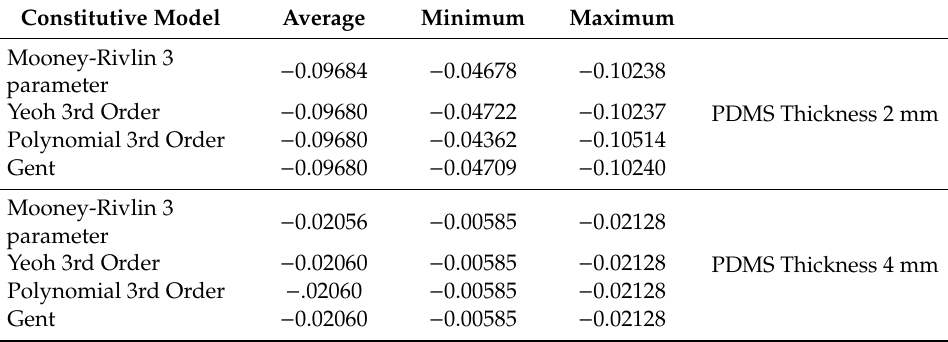
Figure 13. Shear strain obtained numerically and experimentally along the y-direction for 4 mm of PDMS. Table 2. Average, maximum and minimum shear strain values obtained by simulation.